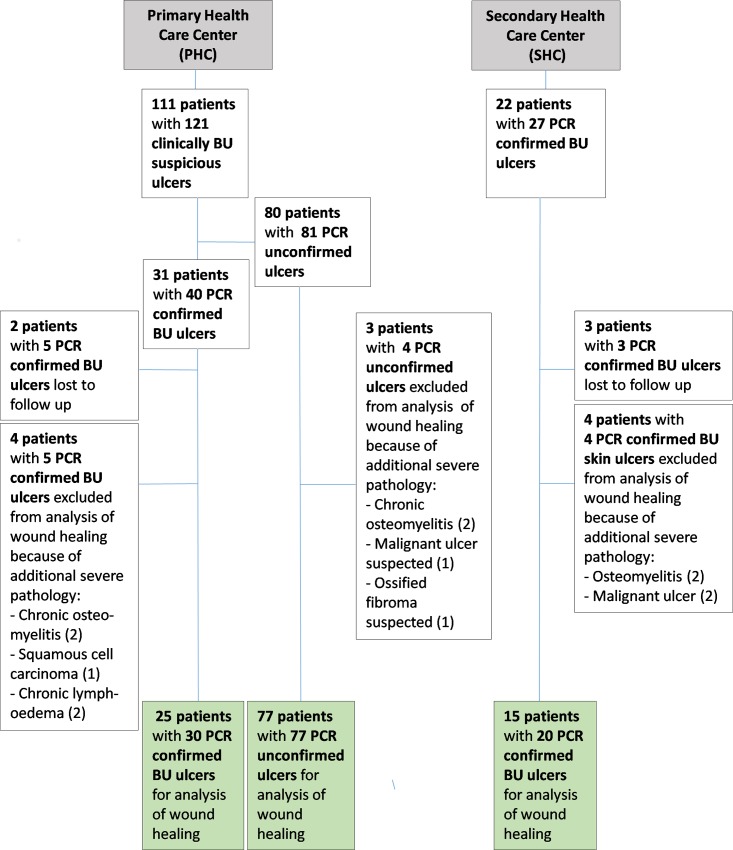
Study algorithm at the PHC center and the SHC center.